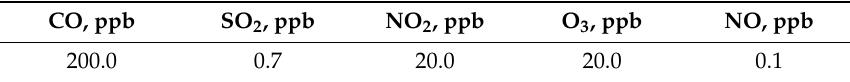
Figure 3. The simulation results at the TOR station carried out by the developed CTM (blue lines) and CAMx (red lines) models. The observations of atmospheric composition are given at the TOR (open circles) and BEC (closed circles) stations. Table 2. Background